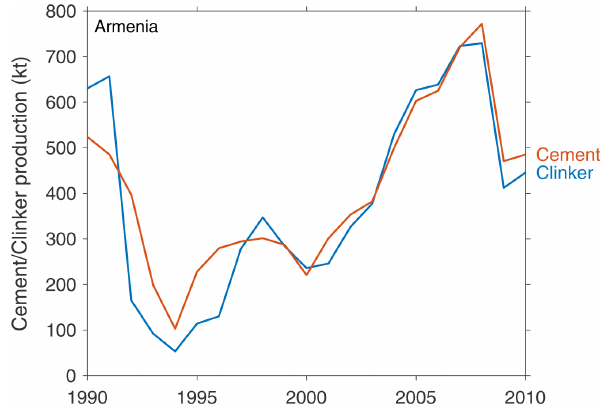
Figure C8. Revised cement emissions for USA.